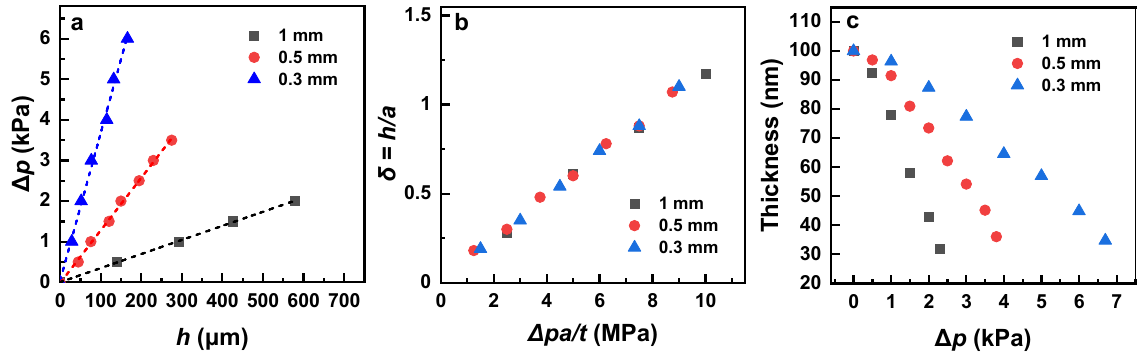
Figure 3. ∆ p vs. h ( a ) and h / a vs. ∆ p · a/t ( b ) plots for the PEG membranes suspended over the circular windows with the different diameters (see the legends); straight lines in ( a ) are tentatively drawn through the experimental points. ( c ) Thickness of the membranes as a function of ∆ p .